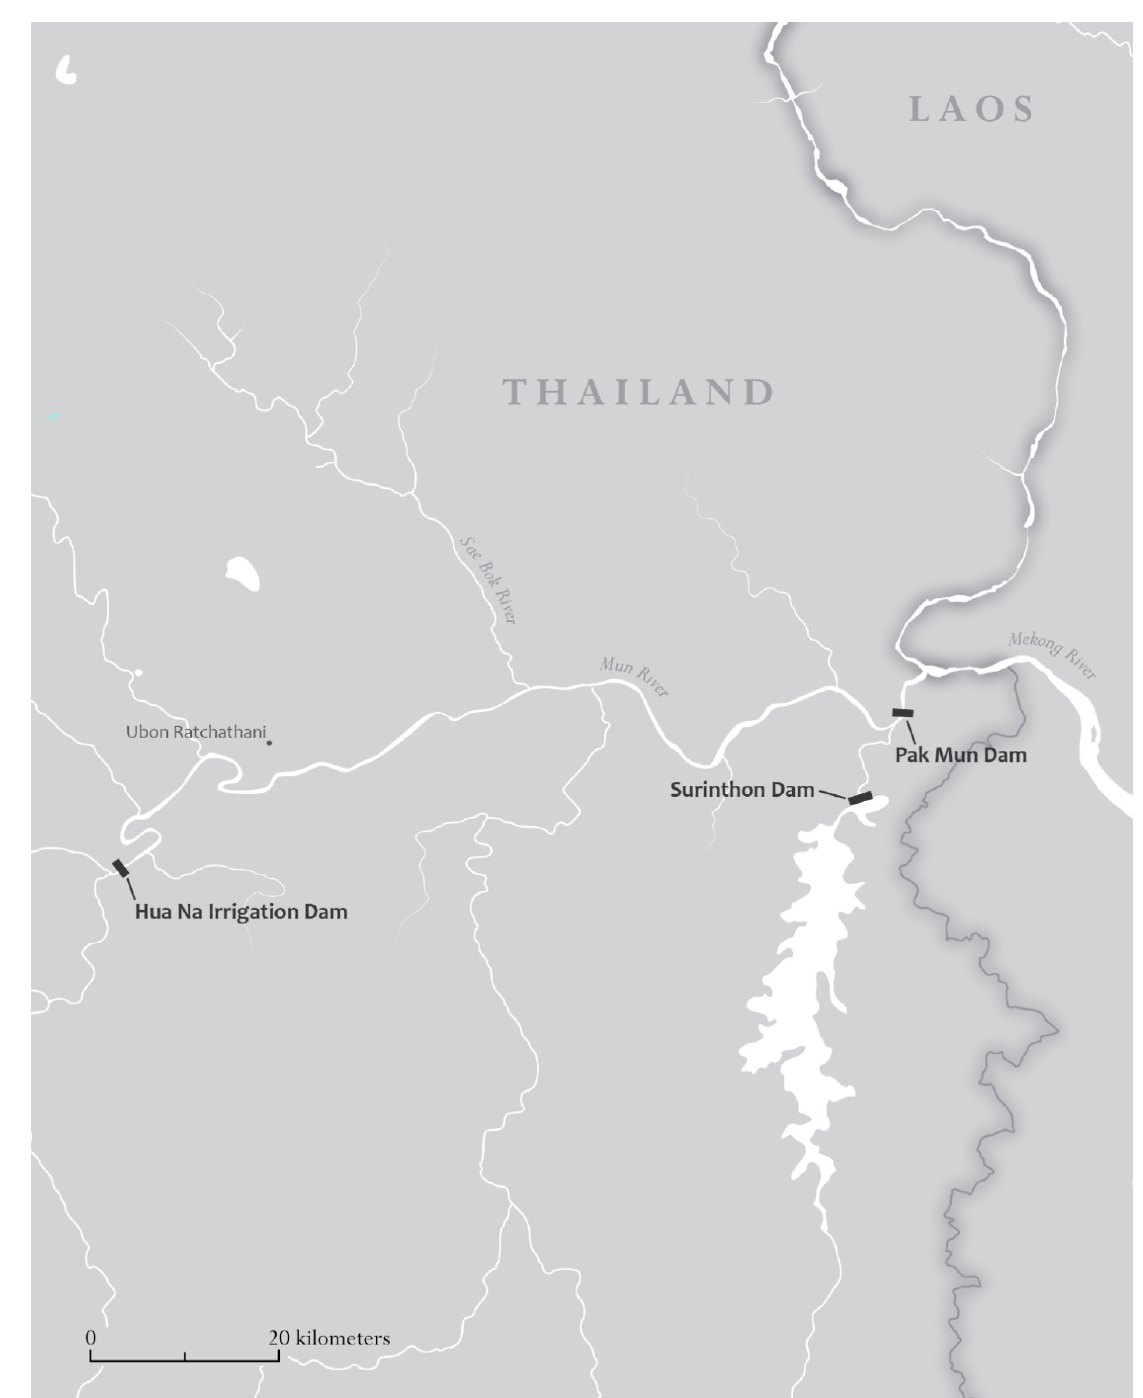
Figure 3. The Lower Mun River Basin, including the Pak Mun, Hua Na, and Surinthon dams, northeastern Thailand. For local peoples, the costs of the Pak Mun Dam far outweigh the benefits [7,8,20,71]. First, the dam was never meant to be part of a local or regional development project but was rather developed to supplement the national power grid of Thailand [71]. However,